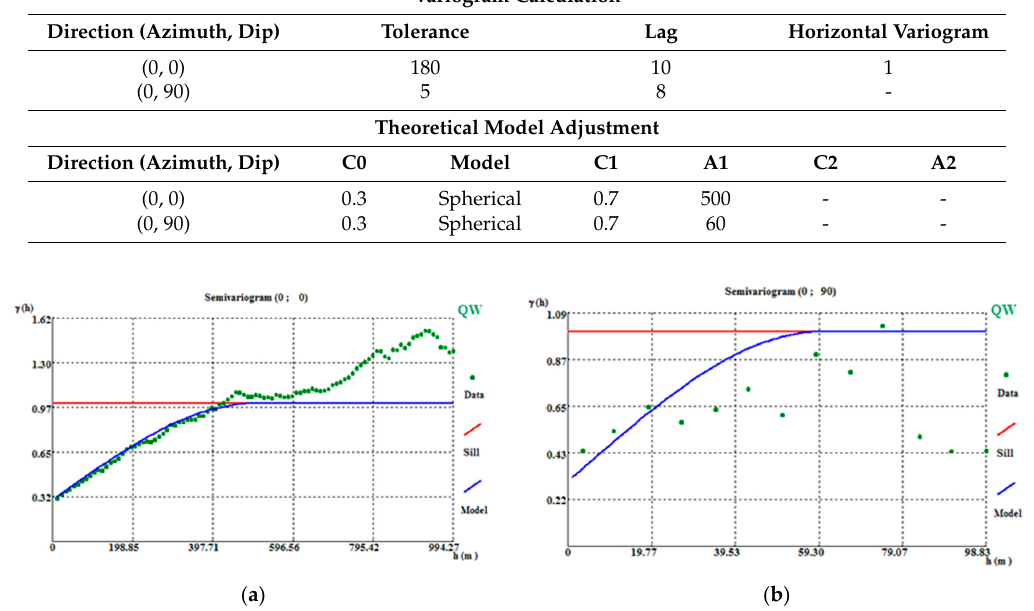
Figure A10. Borehole CL1 indicator variable directional variograms: ( a ) horizontal variogram and ( b ) vertical variogram. On a 50 m × 50 m × 30 m grid. Table A10. Calculation and adjustment parameters for the stope vein proportion variograms.